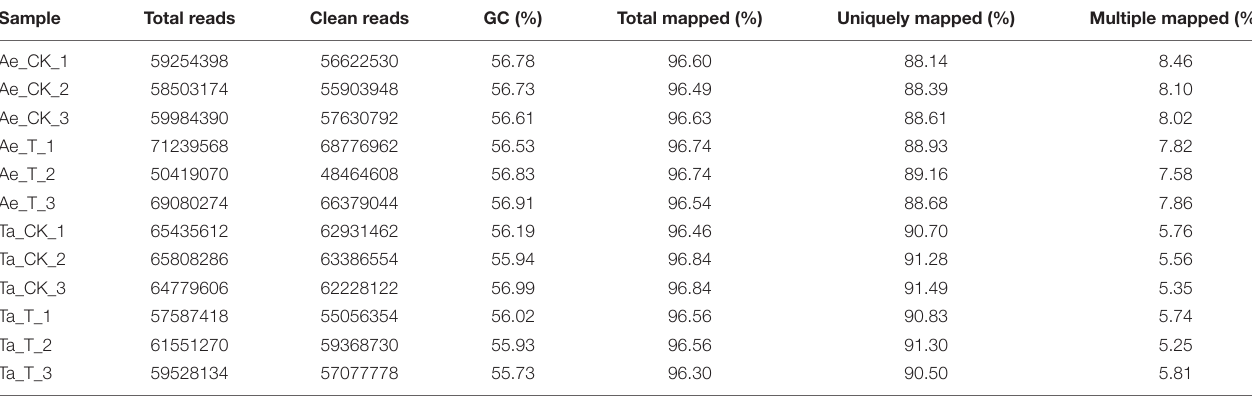
TABLE 1 | Summary of RNA sequencing and mapping using the Triticum aestivum genome ( Triticum _ aestivum _release42) as the reference a . Sample